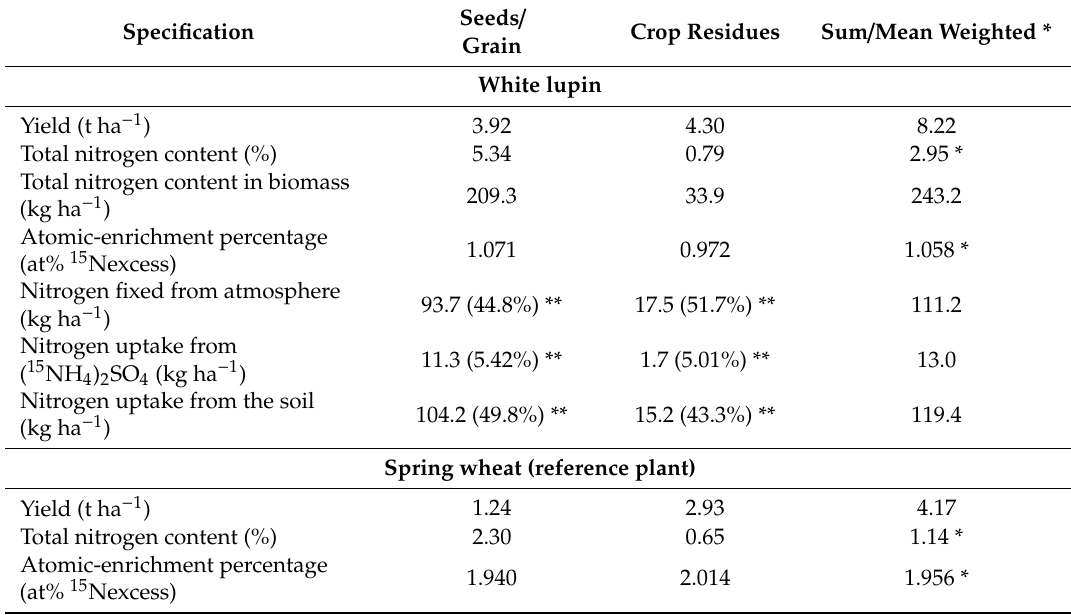
Table 3. Parameters of white lupin and spring wheat (reference plant) harvested in